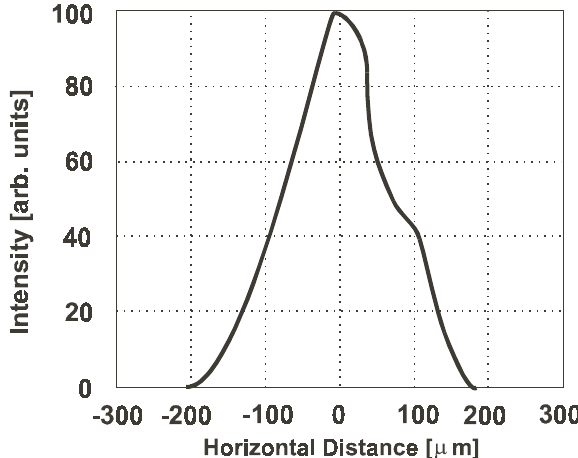
FIG. 4. Bremsstrahlung x-ray signal observed upon transverse scanning of the e beam with the 50 m m thick metal wire.